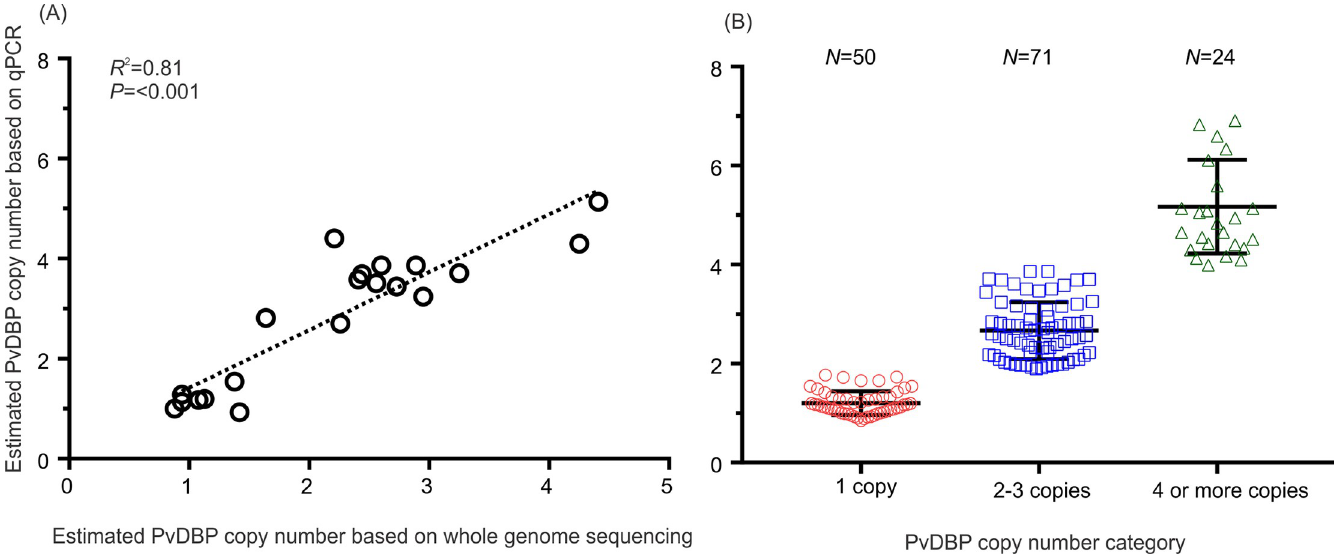
Fig 2. Comparison of PvDBP copy number estimated using different approaches. (A) A scatter plot showing PvDBP copy number estimated by quantitative real- time polymerase chain reaction (y-axis) and by PvDBP coverage in whole genome sequencing (x-axis) of 20 symptomatic P . vivax samples. Regression coefficient and P - value were indicated. (B) A dot plot showing PvDBP copy number detected by quantitative real-time PCR of all 145 symptomatic P . vivax samples by three different copy number categories. The geometric median and standard deviation of the data were indicated.